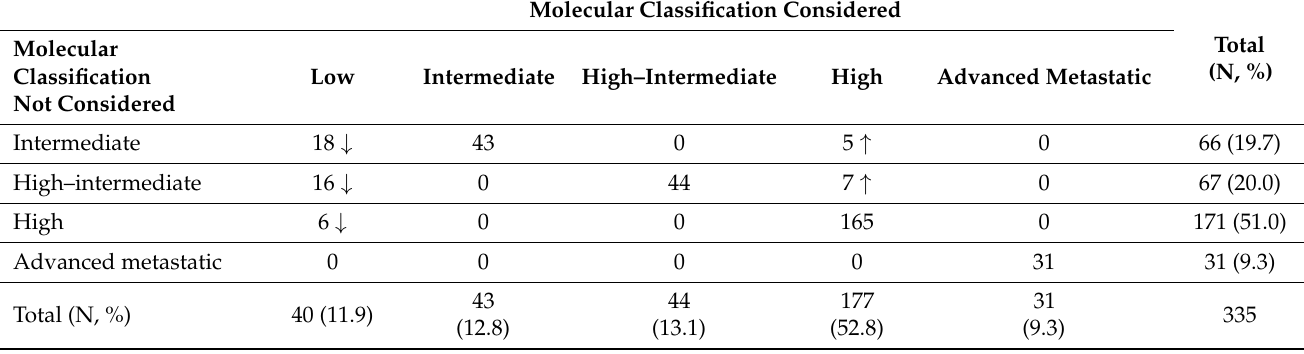
Table 4. Concordance and shift between risk groups when considering vs. not considering molecular classification